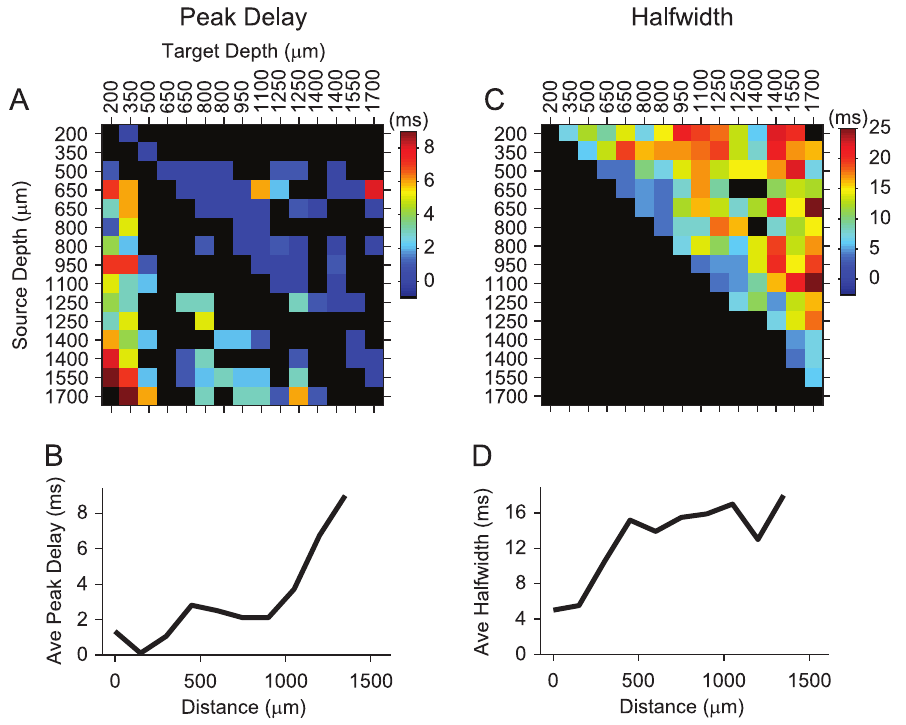
Figure 5. Example temporal interaction parameter matrices for neurons in an AI column. Data from example penetration in Fig. 1. Matrix values are indexed according to specific neuron combinations indicated by the depths listed above and to the left of the plots in (A, C). (A) Peak delays from cross-covariance functions. Absolute values of peak delays are shown. Each element in the matrix is in Row to Column form, (Row, Column), which implies that the connection was from Row to Column . The signs ( + or 2 ) of peak delays were used to determine the direction of the connection. Black matrix elements indicate non-significant connections or connections not consistent with cross-covariance functions. (B) Average peak delay as a function of intra-columnar distance between neurons for the data in (A). (C) Halfwidths of cross-covariance functions. Values below the diagonal are not shown since the matrix is symmetric. Black matrix elements above the diagonal indicate non-significant connections. (D) Average halfwidth versus intra-columnar distance between neurons for the data in